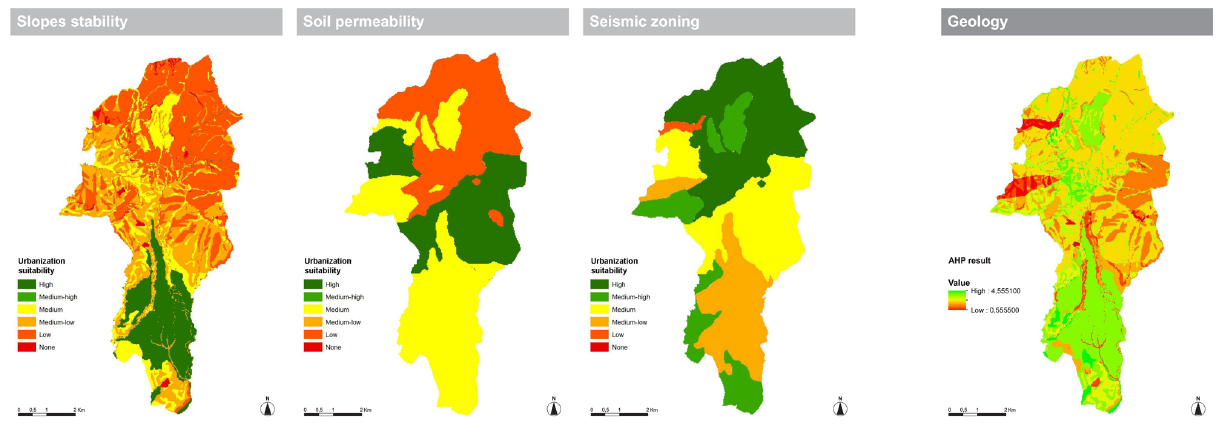
Fig. 3. Urbanization suitability maps: geology.